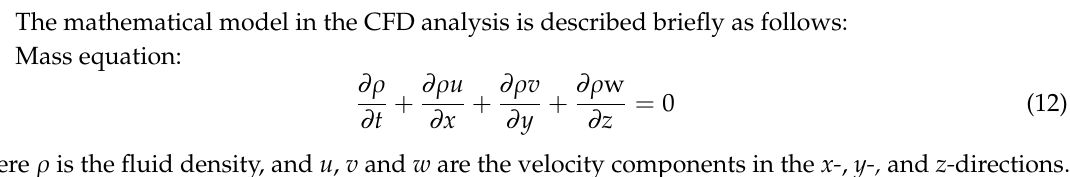
Figure 2. Geometrical parameters of a low-temperature-differential gamma-type Stirling engine.